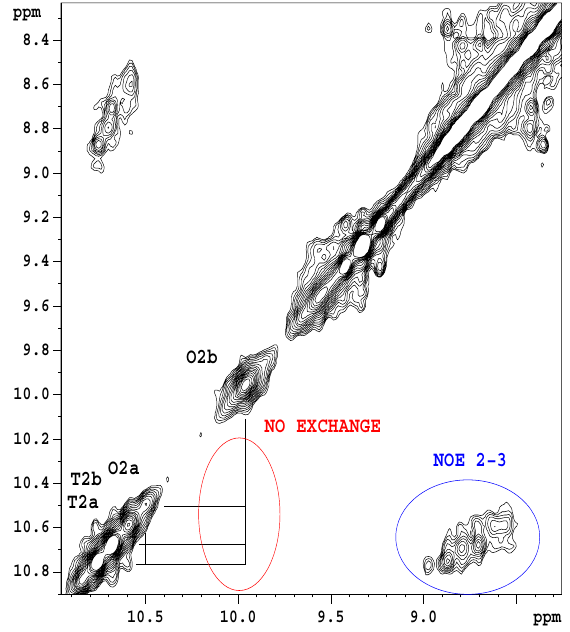
Figure 11. Schematic arrangement of the oligomers in open or closed conformations. Pink spots represent the ligands that can help to form face ‐ to ‐ face interfaces between glycopeptide monomers.